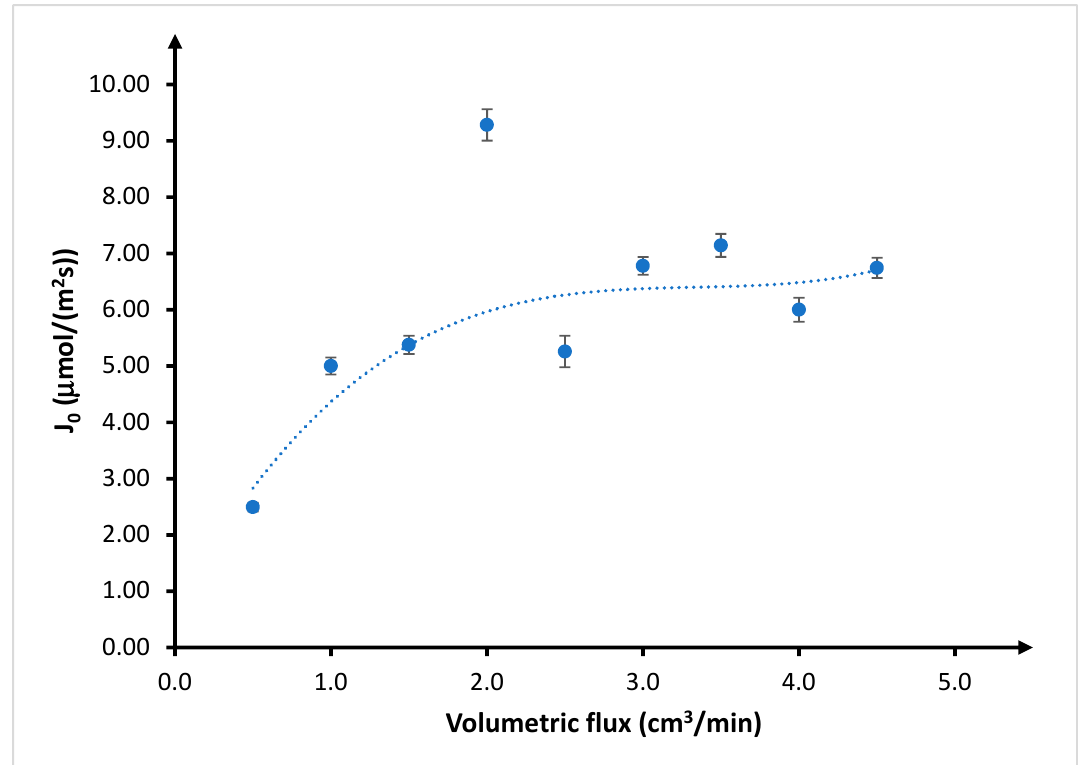
µ mol · m − 2 · s − 1 ) depending on volumetric flow rate of feed Figure 4. Initial copper(II) flux (J 0 , μ mol ∙ m − 2 ∙ s − 1 ) depending on volumetric flow rate of feed and Figure 4. Initial copper(II) flux (J 0 ,